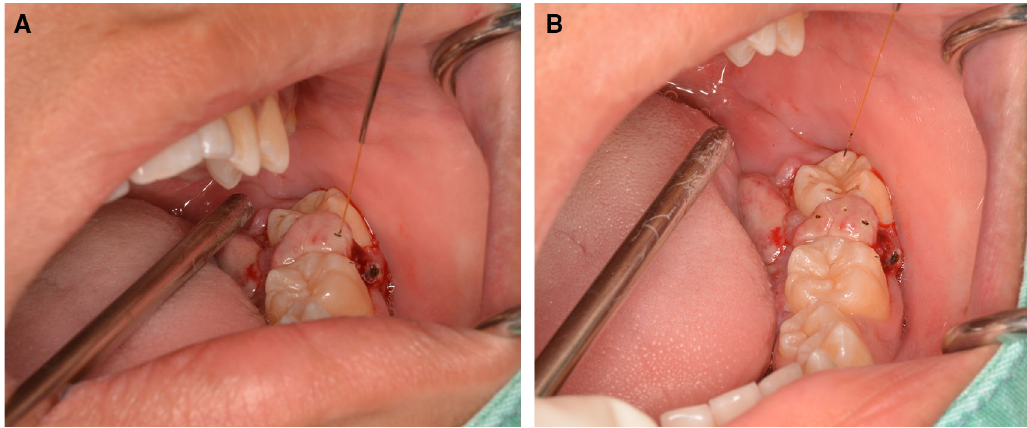
Figure 4. The interstitial-intralesional laser technique. A.The optical fiber was inserted into the lesion, beginning at the base of the lesion and then progressing to the top. The optical fiber was placed tangentially to the tooth and root surface. B. After a single treatment with interstitial-intralesional laser therapy on four areas.